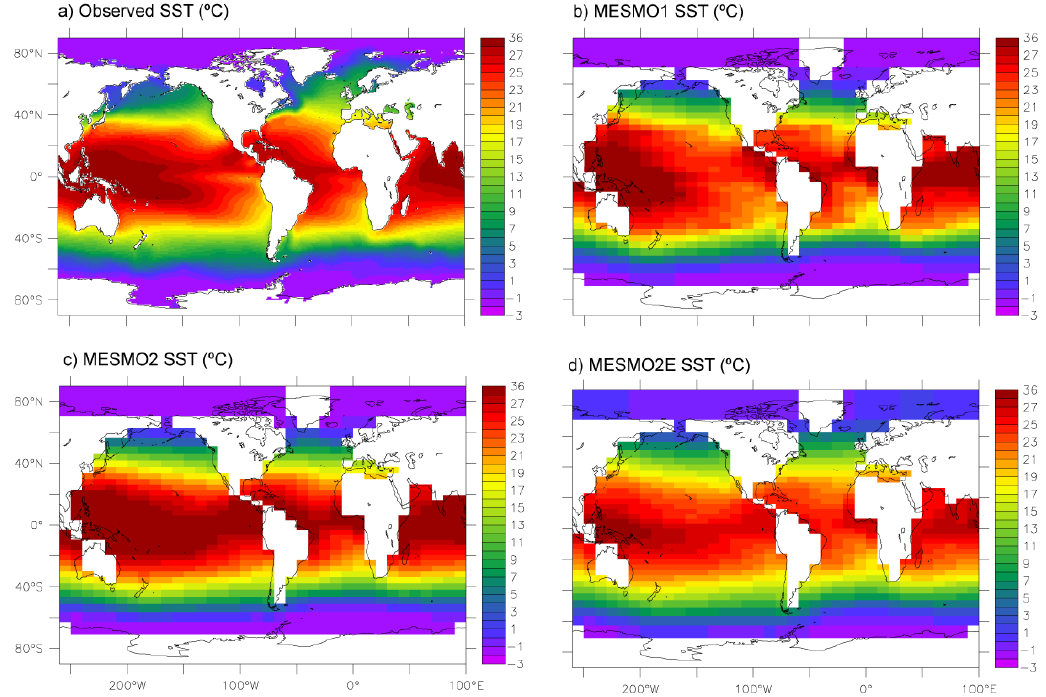
Fig. 5. Observed and model-simulated mean annual sea surface temperature (top 45m). Observations are based on the World Ocean Atlas 2009 (Locarnini,